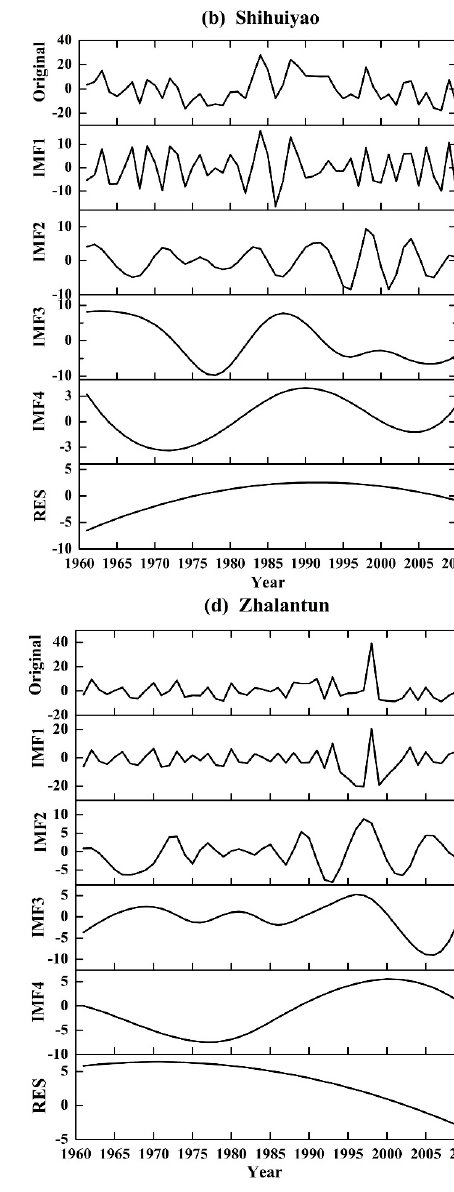
Figure 2. Annual streamflow anomaly against the 1961–2010 average and a five-year moving average trend at six gauge stations (( a ) Beian, ( b ) Shihuiyao, ( c ) Xiaoergou, ( d ) Zhalantun, ( e ) Suolun and ( f ) Tuliemaodu) in the headwater region of the Nenjiang River Basin, Northeast China.